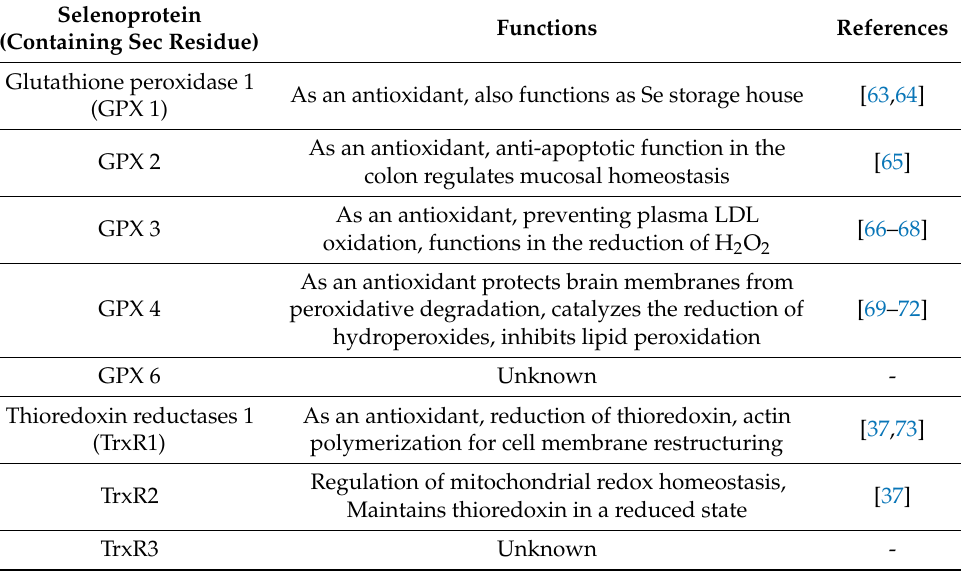
Table 1. Functions of some of the selenoproteins.